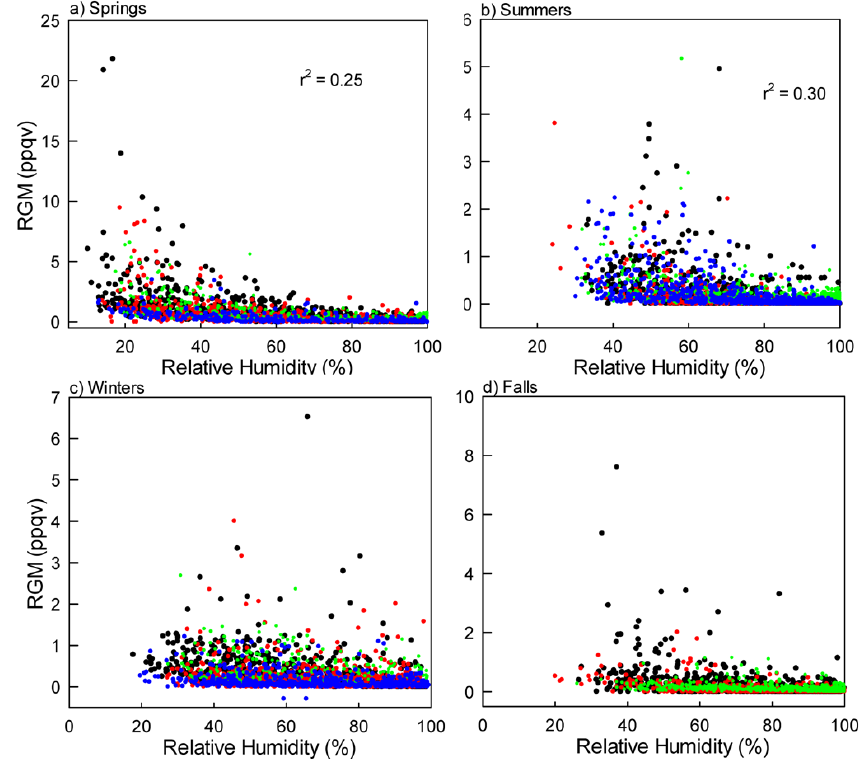
Fig. 14. Relationships between RGM and relative humidity at TF (coastal) in (a) springs, (b) summers, (c) falls, and (d) winters with data from 2007 in black, 2008 in red, 2009 in green and 2010 in